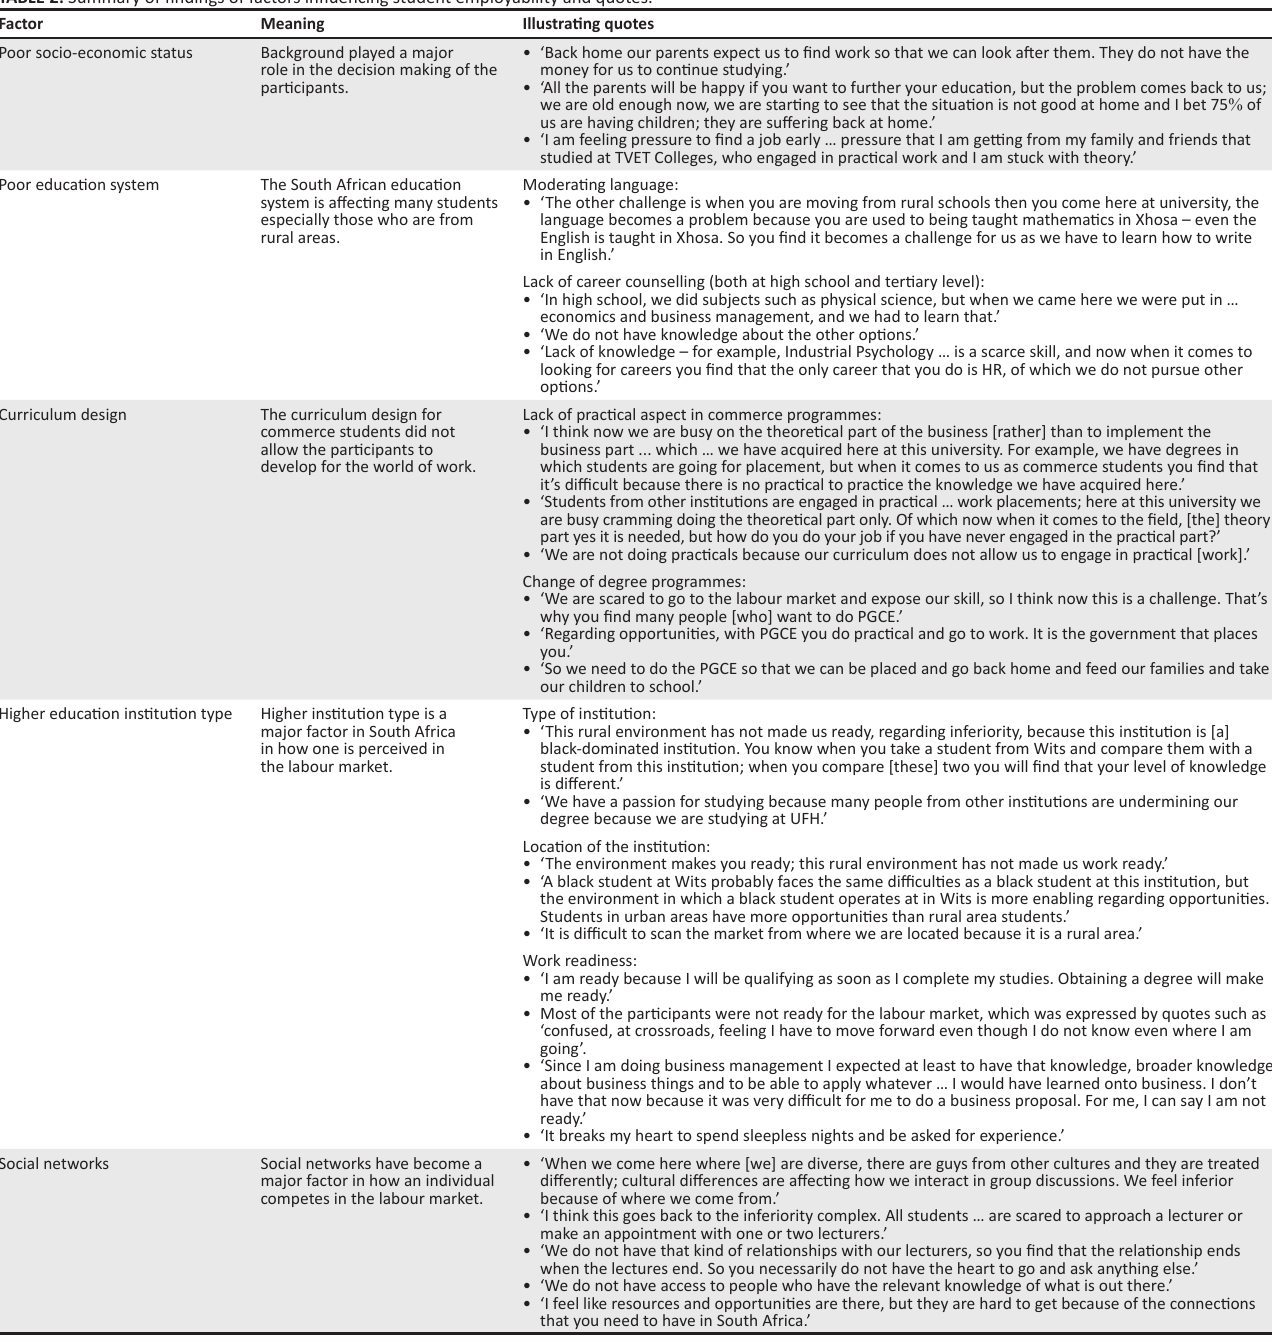
TABLE 2: Summary of findings of factors influencing student employability and quotes. Factor Meaning Illustrating